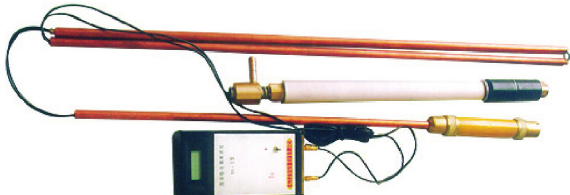
Figure 7: The ultrasonic detection analyzer unit.